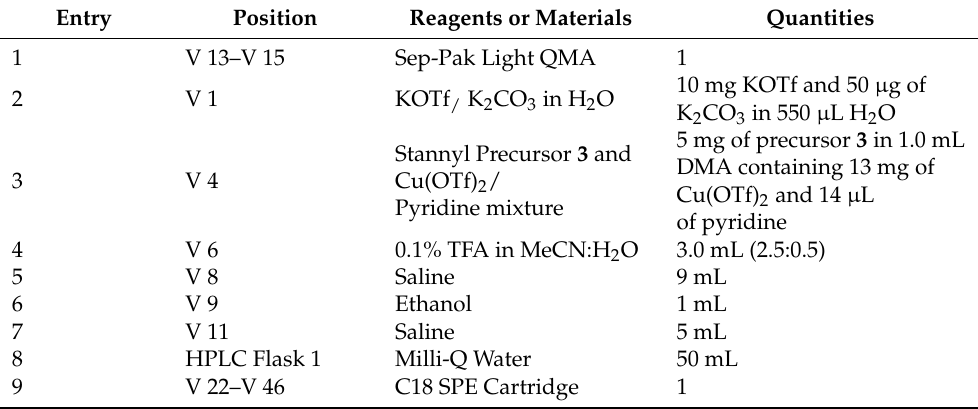
Table 2. Preparation details for the automated production of [ 18 F]FMZ 1 using the iPHASE Flexlab radiochemistry